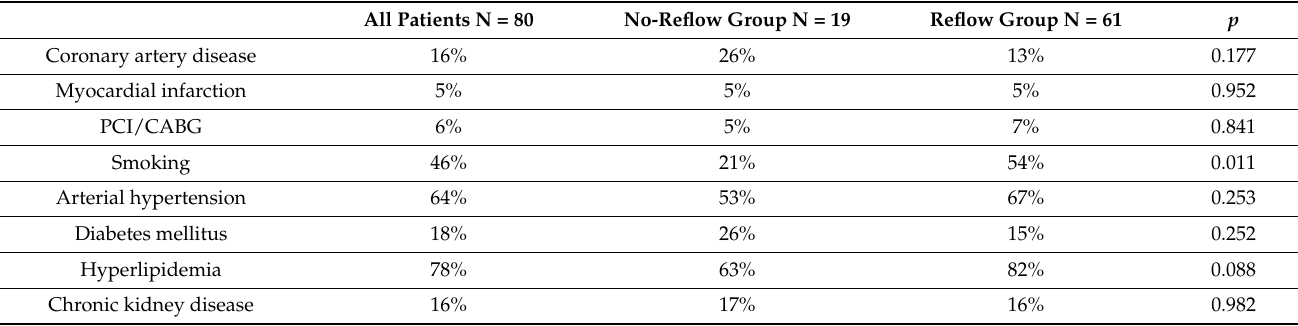
Table 3. Past medical history data.